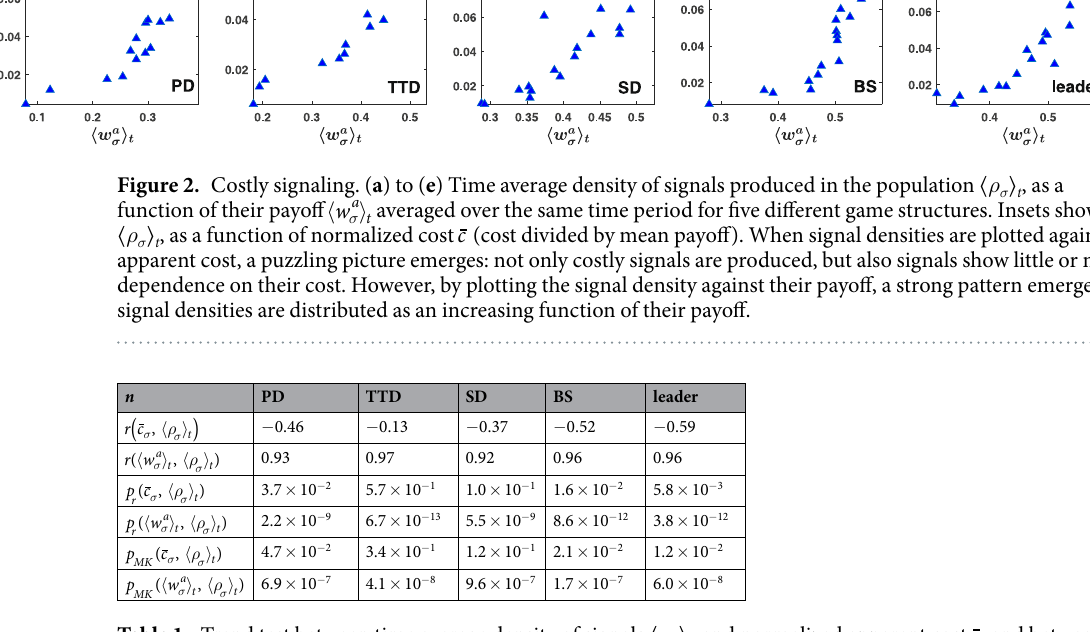
Table 1. Trend test between time average density of signals 〈 ρ σ 〉 t , and normalized apparent cost c , and between 〈 ρ σ 〉 t and time average payoff of signals 〈 〉 σ w a t in different games. From top to down, Spearman’s rank correlation , p value of the Spearman test between 〈 ρ σ 〉 t and c , coefficient between 〈 ρ σ 〉 t and c , and between 〈 ρ σ 〉 t and 〈 〉 σ w a t and between 〈 ρ σ 〉 t and 〈 〉 σ w a , and finally, p value of the Mann-Kendall test between 〈 ρ σ 〉 t and c , and between t 〈 ρ σ 〉 t and 〈 〉 σ w a t . Here, an average over a window of length 5000 time steps is taken. In all the cases both tests strongly support a trend between payoff and density of signals, but in the case of TTD and SD, fail to establish a trend between the apparent cost and density of signals. In all the cases, the trend between density and fitness is significantly stronger compared to the trend between apparent cost and